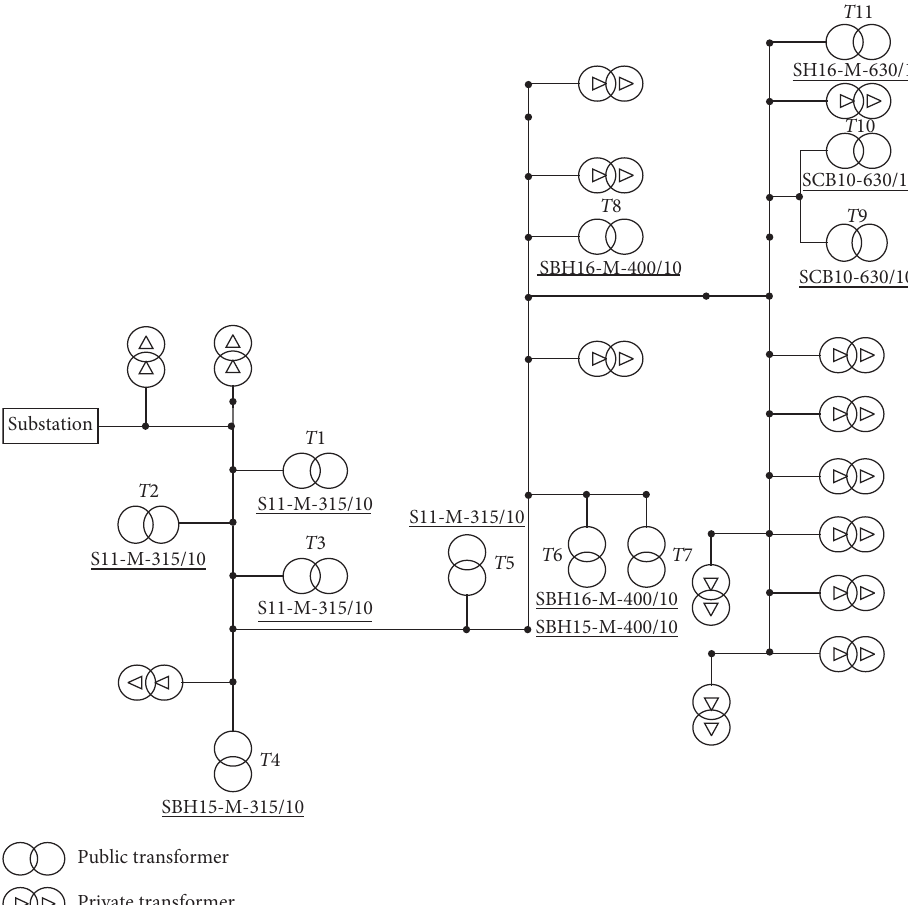
Figure 4: The selected feeder topology for loss reduction.